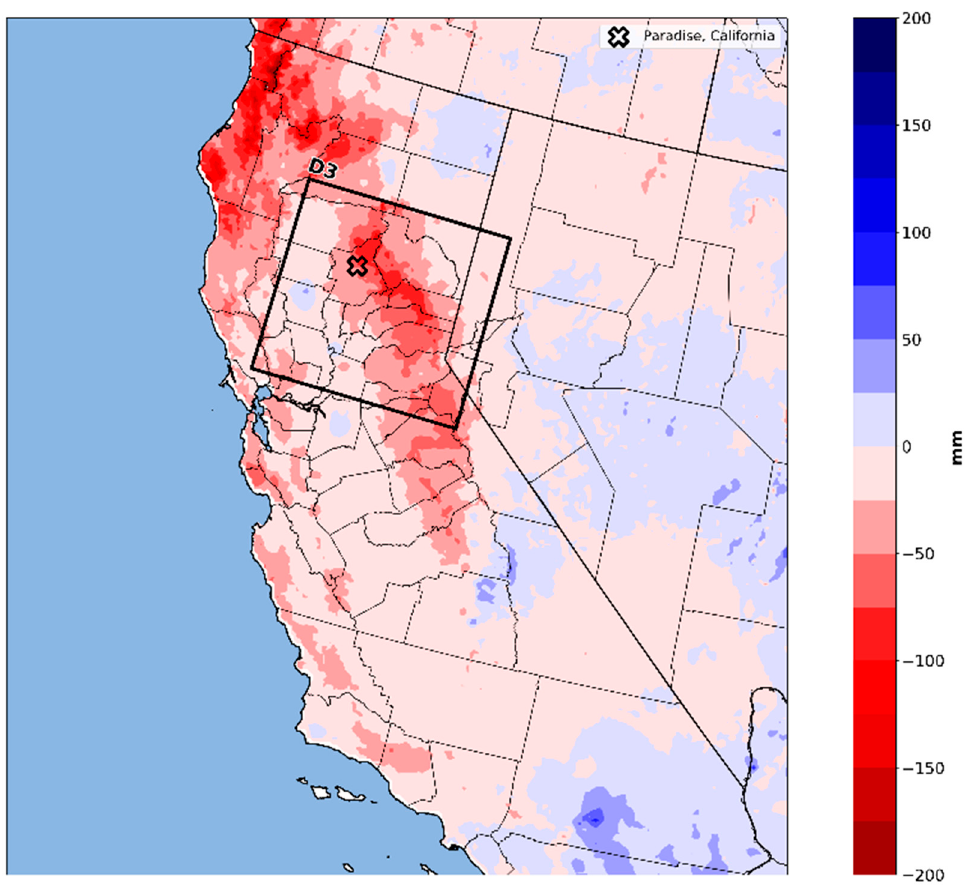
Figure 2. National Weather Service (NWS) advanced hydrologic precipitation service quantitative precipitation estimate departures from normal based on 1981–2010 climatology.